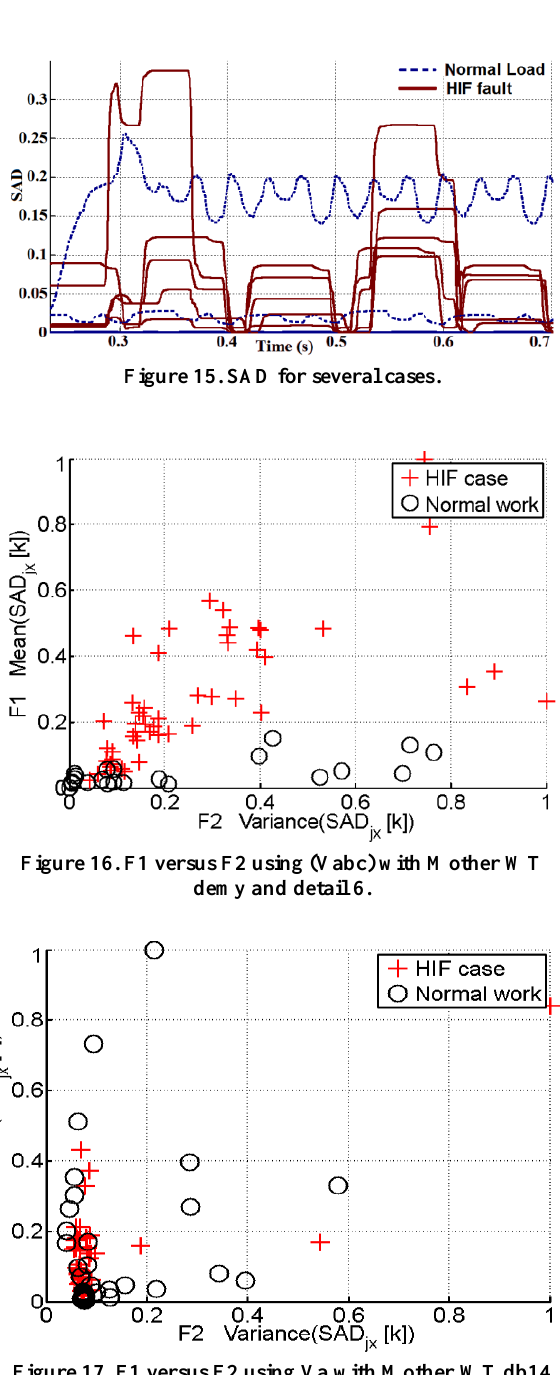
Figure 17. F1 versus F2 using Va with Mother WT db14 and detail 7.